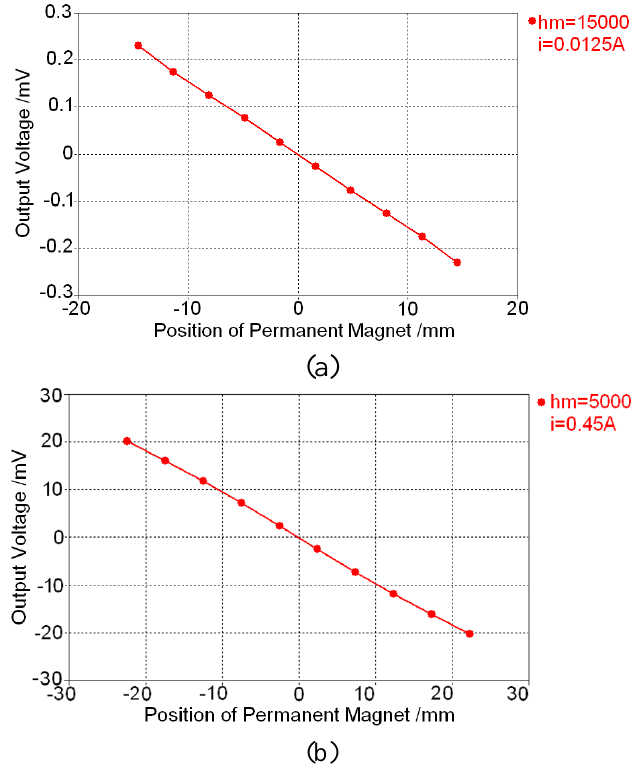
Figure 14. Low frequency calculation results under different working